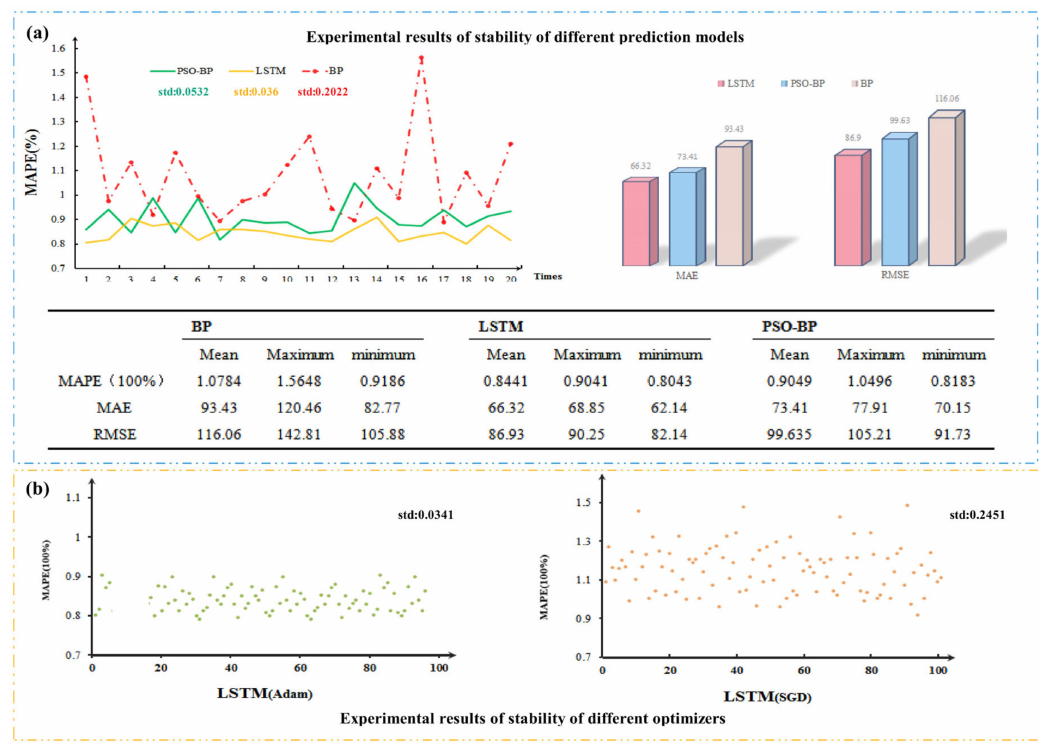
Figure 7. Prediction performance and stability of the STM neural network and Adam optimizer with the Queensland datasets. ( a ) Experimental results stability of di ff erent prediction models. ( b ) Experimental results of stability of di ff erent